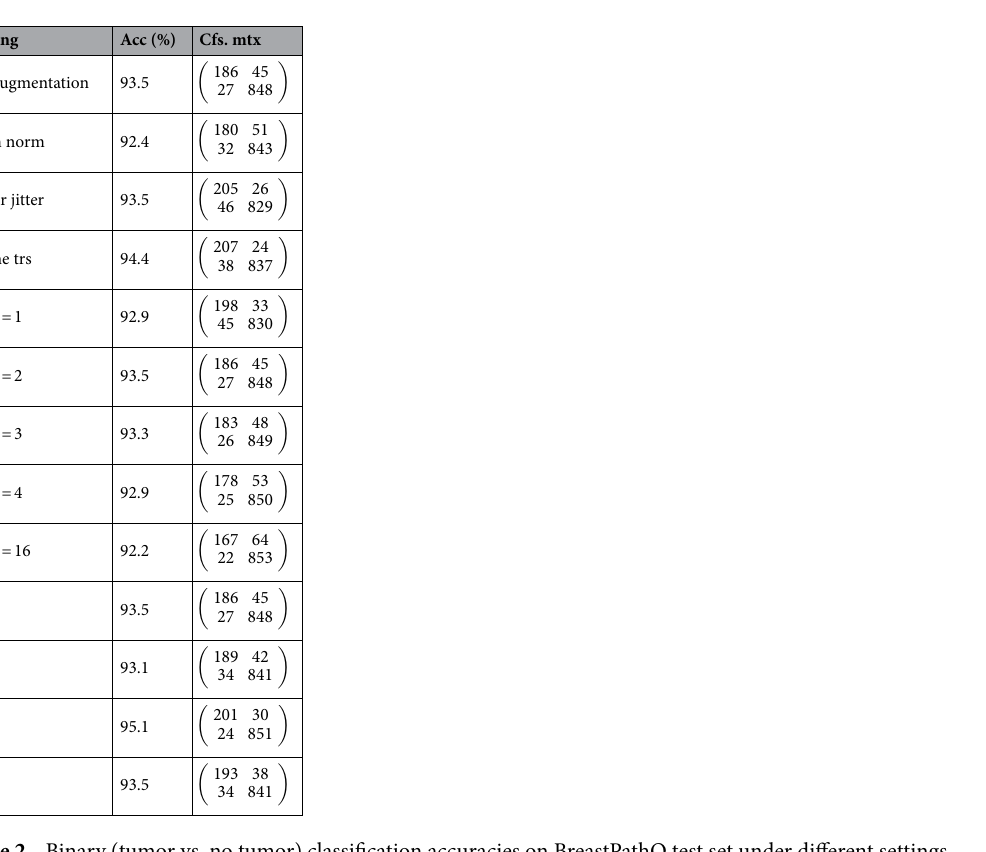
Table 2. Binary (tumor vs. no tumor) classification accuracies on BreastPathQ test set under different settings. Unless otherwise stated, test-time augmentations (TTA) are set to